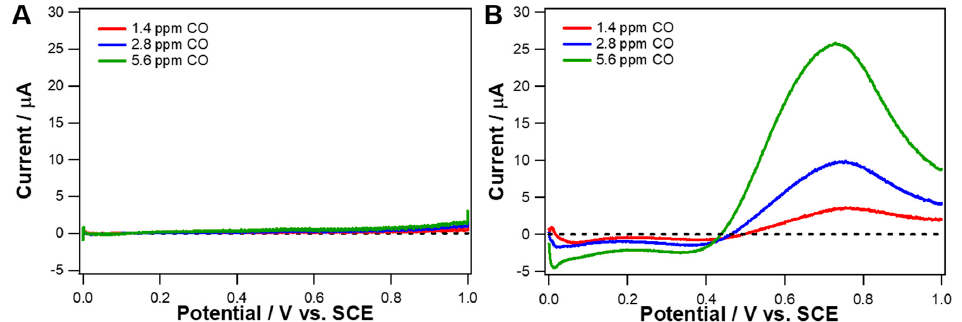
Figure 5. Background-corrected linear sweep voltammetry (LSV) curves of ( A ) IrO 2 nanotubes- and ( B ) Ir metal nanotubes-loaded glassy carbon (GC) electrode obtained in aqueous solutions at 1.4 ppm (red), 2.8 ppm (blue), and 5.6 ppm (green) of CO concentration. Background solution contains 0.5 M H 2 SO 4 and 0.03 M NaCl, which is deaerated via Ar gas purging. Scan rate 10 mV s − 1 .